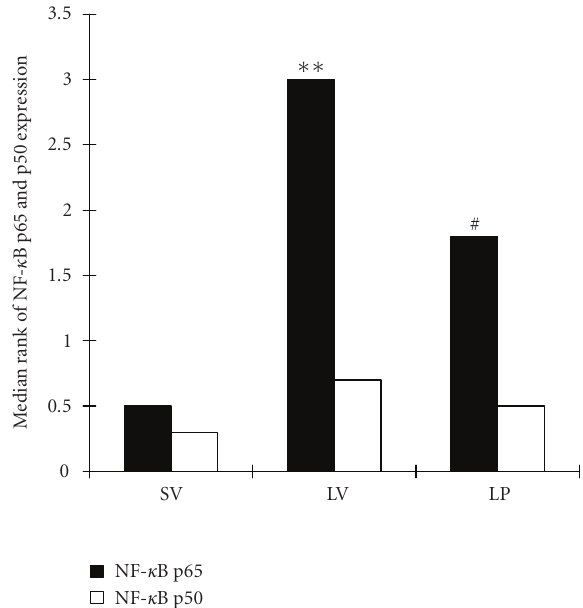
Figure 4: NF- κ B p65 and p50 grades in the small intestines in SV group (sham + vehicle, n = 6), LV group (lesion + vehicle, n = 6), and LP group (lesion + progesterone, n = 6). Administration of progesterone remarkably inhibited TBI-induced up-regulation of NF- κ B p65 expression in rat ileum tissue. The NF- κ B p50 expres- sion in ileum was not significantly di ff erent among groups of SV, LV and LP. ∗∗ P < . 01 versus SV group; # P < . 05 versus LV group.